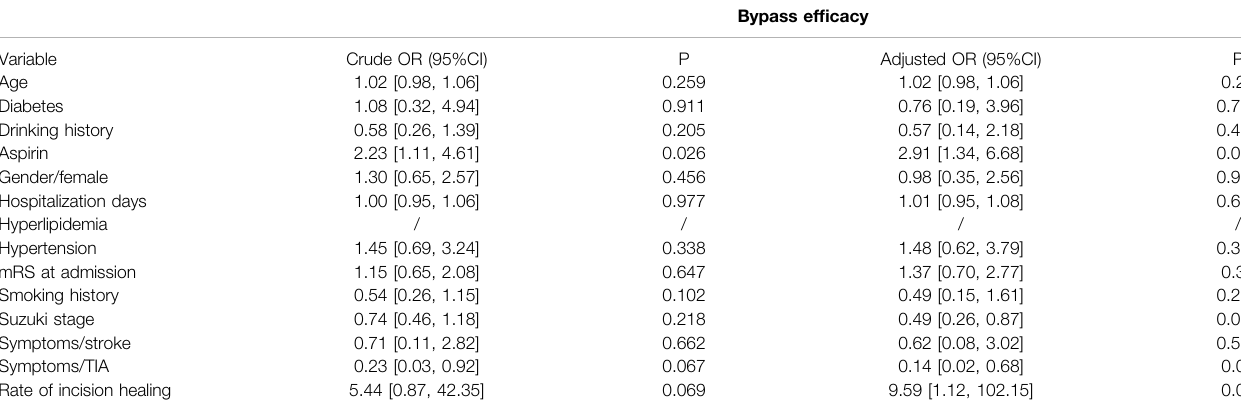
TABLE 3 | Association of patient features with bypass ef fi cacy.